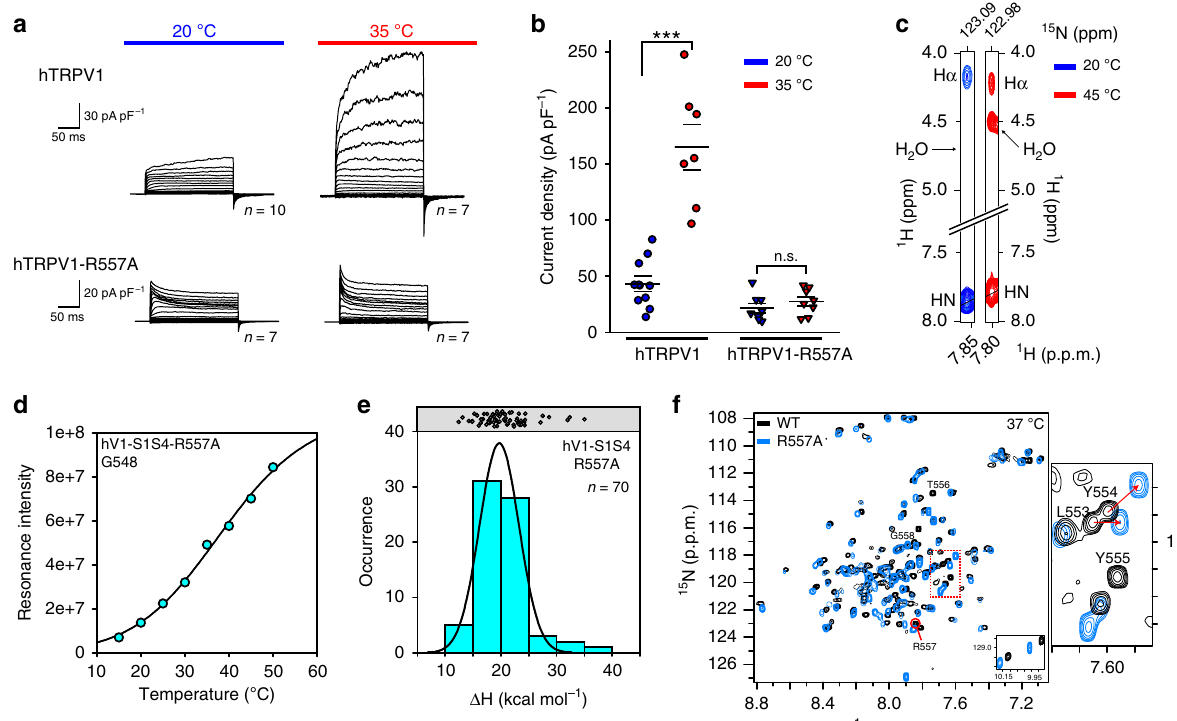
Fig. 5 TRPV1 R557 is a crucial residue for coupling between the S1 – S4 and pore domains. a , b Whole-cell patch-clamp electrophysiology data from HEK293 cells show that the wild-type hTRPV1 is heat activated, while the hTRPV1-R557A mutant is not. Error bars in panel ( b ) are s.e.m. c 15 N-edited NOESY-TROSY data of the R557-water resonance cross-peak is missing at low temperature but present at elevated temperature, suggesting that R557 amide backbone moves from a membrane embedded to a solvent-accessible position in a temperature-dependent manner. d NMR temperature titration of hV1-S1S4-R557A. G548 in hV1-S1S4-R557A resonance intensity as a function of temperature shows two-state behavior analogous to the wild-type hV1- S1S4 domain (compare Fig. 2d). e A histogram and a Gaussian distribution fi t of Δ H identify a mean Δ H = 19.7 ± 0.1 kcal mol − 1 for the mutant hV1-S1S4- R557A ( n = 70 residues). The data are suggestive of a temperature-dependent conformational change in hV1-S1S4-R557A. f Comparison of 1 H- 15 N TROSY-HSQC spectra show that the R557A mutation causes perturbation at Y554 supporting that the R557A mutation disrupts the cation – π interaction. Source data are provided as a Source Data fi